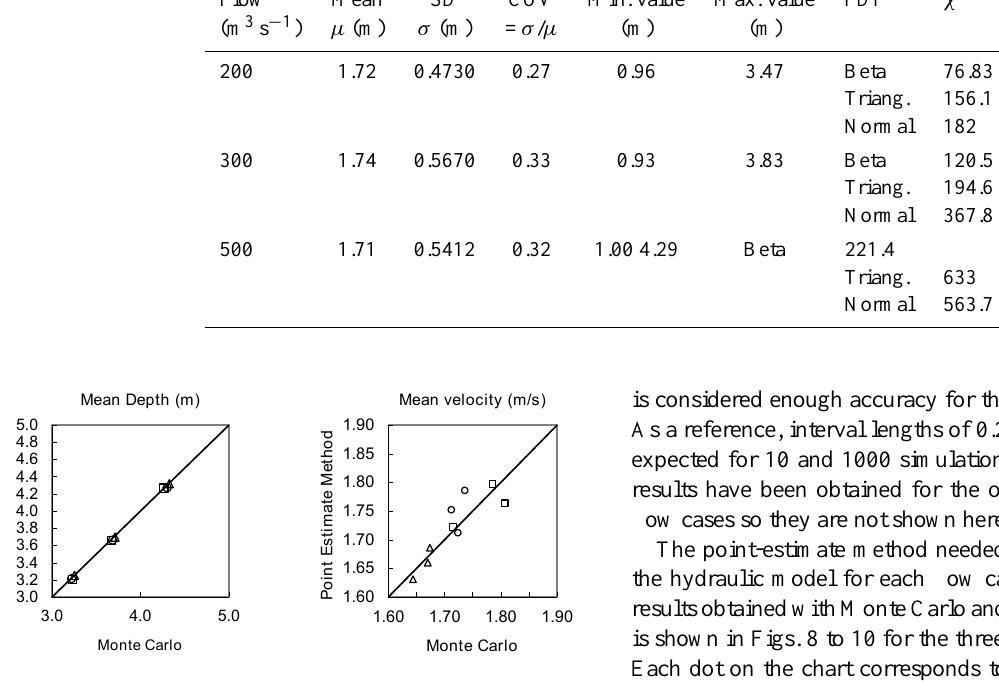
Table 7. Uniform flow model. Adaptation of PDFs to water depth with normal distributions for n i (1000 simulations). Flow Mean COV Min. value